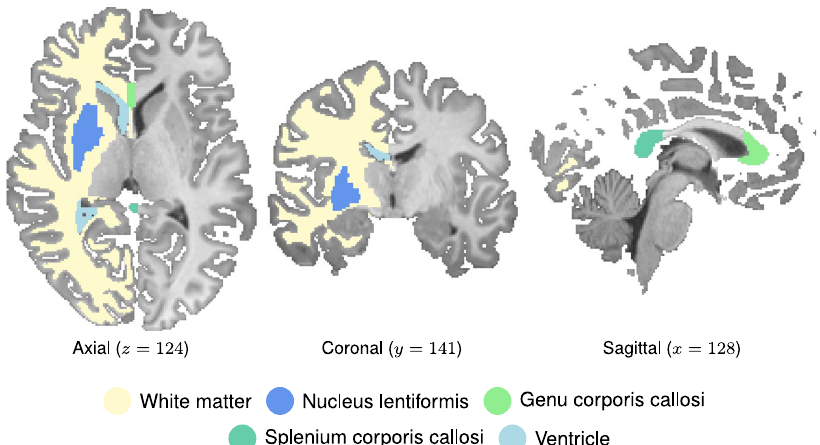
Fig. 2 Regions of interest (ROIs). Axial, coronal, and sagittal slices showing the color-coded ROIs for white matter, nucleus lentiformis, genu and splenium corporis callosi, and ventricles overlaid onto the right hemisphere (radiologic convention) of anatomical T1-weighted images.